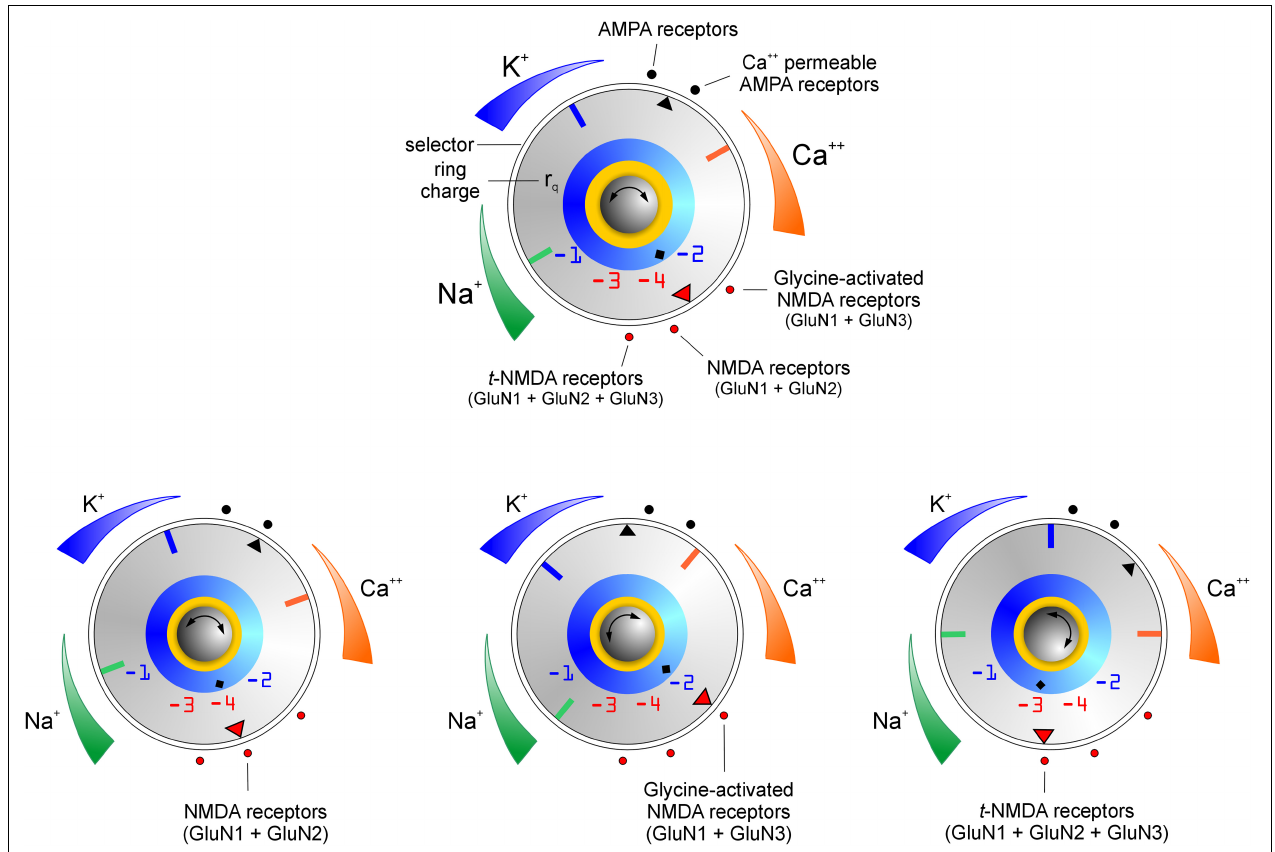
FIGURE 7 | Schema for cation selectivity within ionotropic AMPA and NMDA receptors ( top panel ) with related examples ( bottom panels ). The rotary knob (center) is marked with a channel-selector ( (cid:72) ) and three orthogonally oriented indicators (blue, green and red) for read out of K + , Na + and Ca 2 + selectivity in the chosen receptor channels ( • ) arranged along the periphery of a selectivity dial ( (cid:7) indicates the ring charge r q associated with their selectivity filters). Cation selectivity levels which influence permeability, are graded (high ↔ low) and color-coded (non-colored regions indicate non-selective and/or impermeability). Note that emergence of Ca 2 + selectivity entails loss of Na + /K + selectivity, however their permeability through these channels varies as a function of r q or receptor subunit